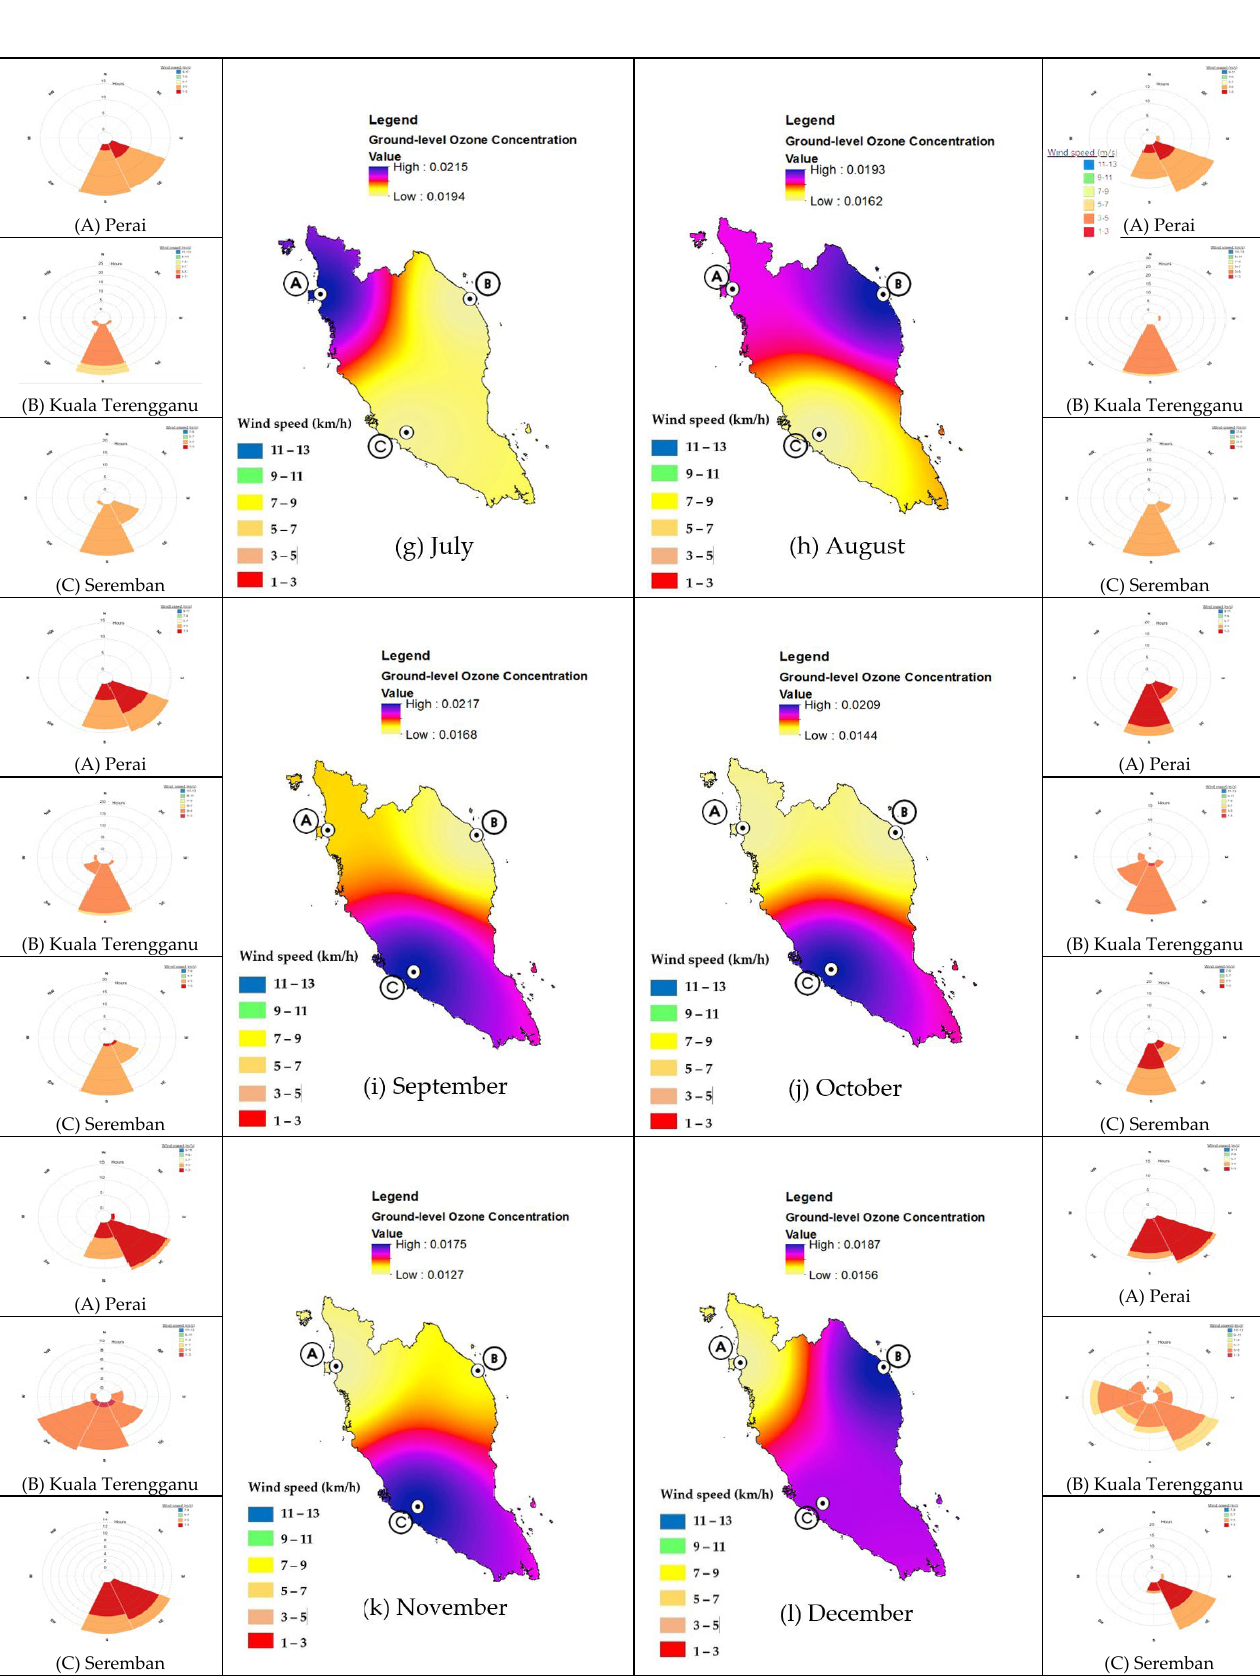
Figure 3. Monthly contour plot and wind rose diagram of ground-level O 3 in Seremban, Kuala Terengganu and